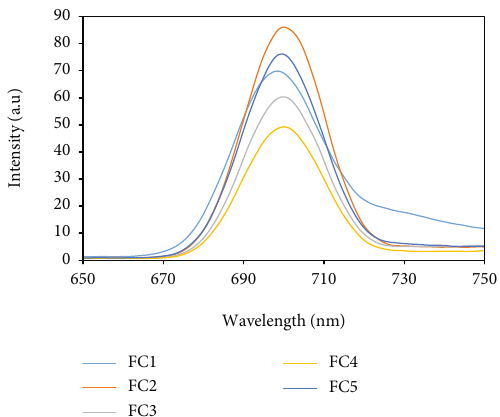
Figure 1: UV-Vis absorption spectra of complexes FC DMSO.